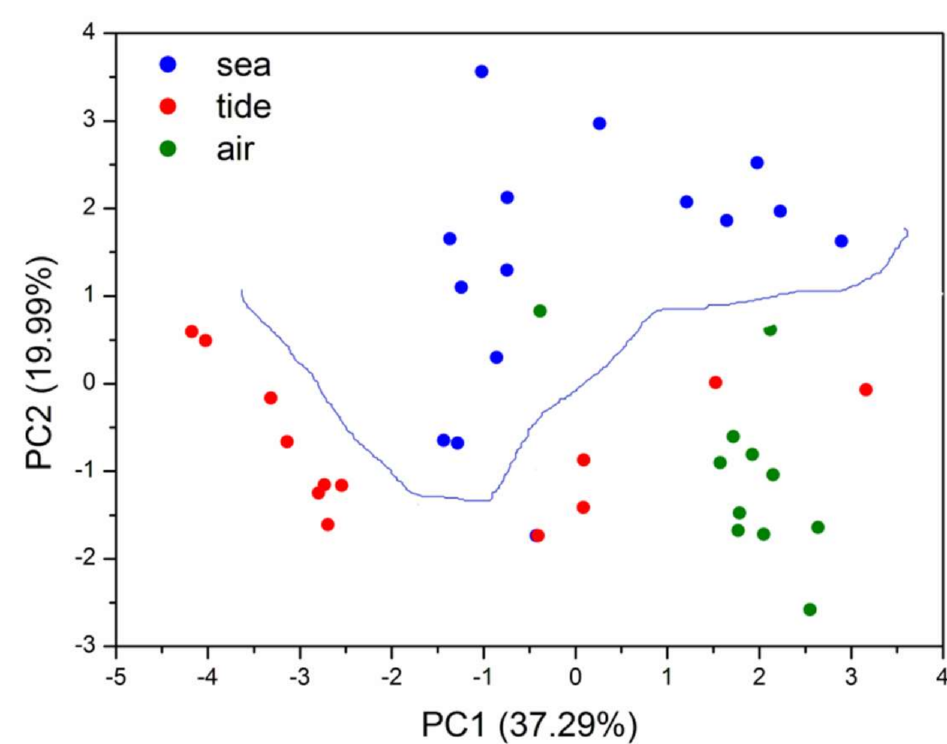
Figure 12. Score plot as a result of PC1 versus PC2 (after 6